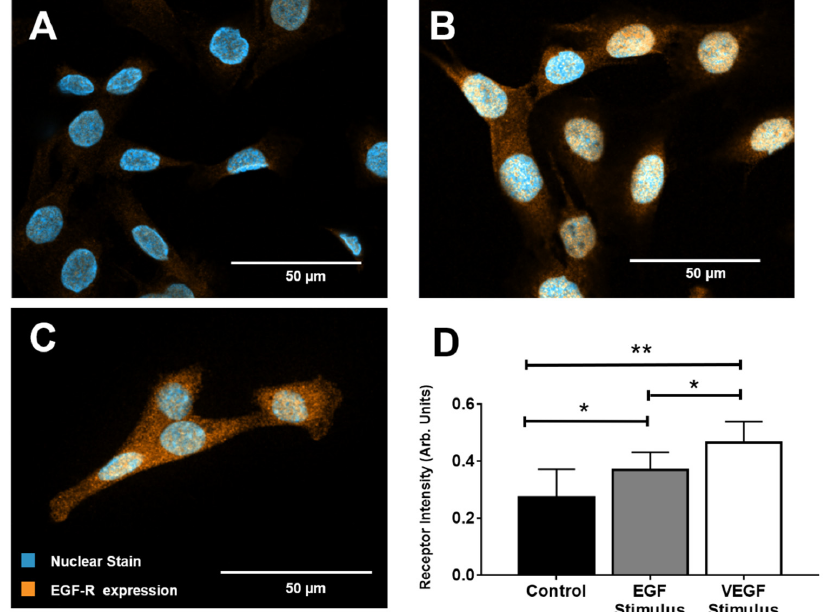
Figure 3. Epidermal growth factor receptor (EGF-R) expression in rMC-1 upon stimulation with epidermal growth factor (EGF) and vascular endothelial growth factor (VEGF). ( A ) Representative image of EGF-R expression in rMC-1 at basal conditions. ( B ) Image of EGF-R within rMC-1 after stimulus with EGF for 1 h. ( C ) Image of EGF-R expression in rMC-1 following VEGF stimulus for 1 h. Orange denotes EGF-R molecules while blue marks nuclear staining (DAPI). ( D ) EGF-R expression measured using fluorescence intensity in arbitrary units (AU). A minimum of 15 cells per condition were used for these calculations.